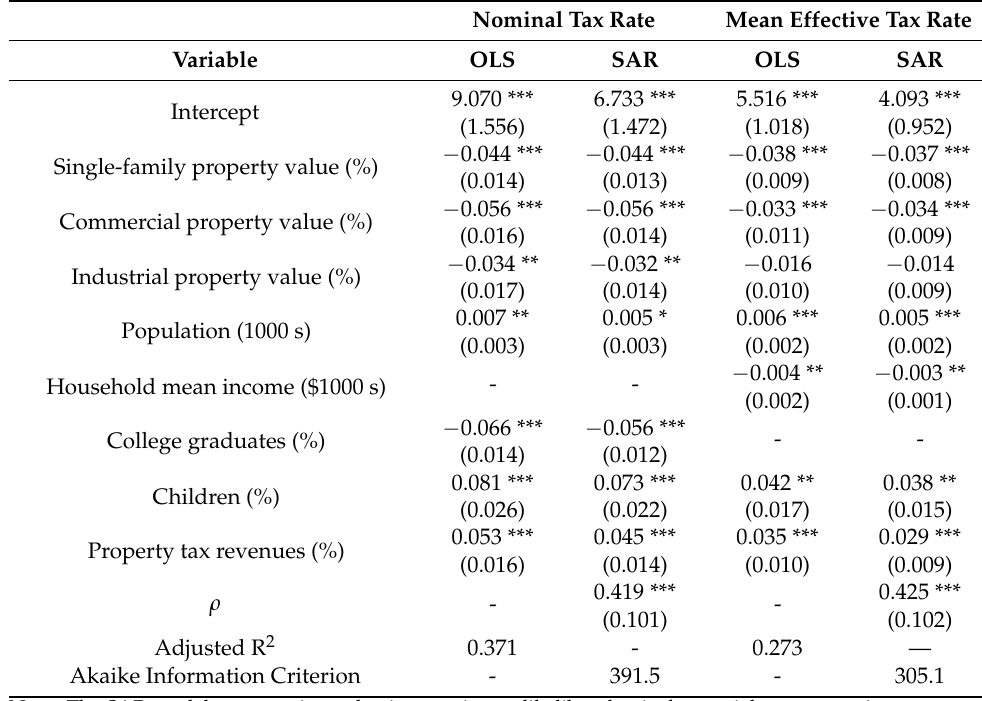
Table 2. Regression results ( n =